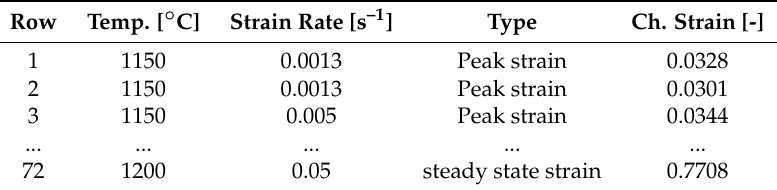
Table 5. Dataset used for training the ANNs to predict the position of the characteristic strains (peak, critical and steady state strain), with the first three rows and the last row shown. Training inputs; temperature, strain rate and parameter type. Target output; characteristic strain.